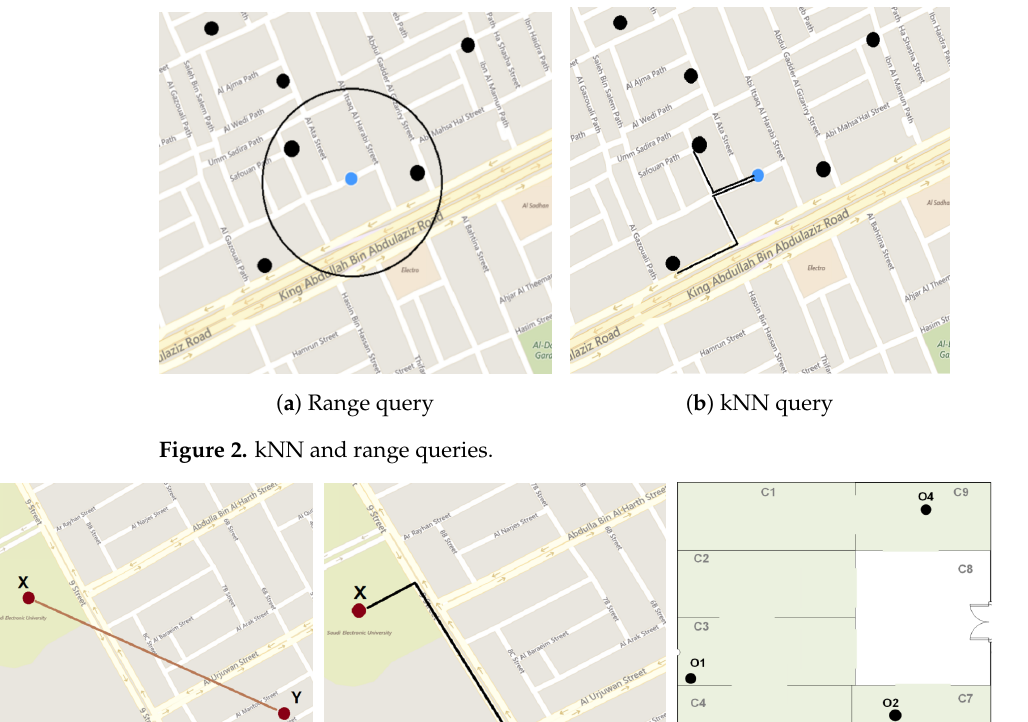
Figure 1. Spatial objects in Google Maps.